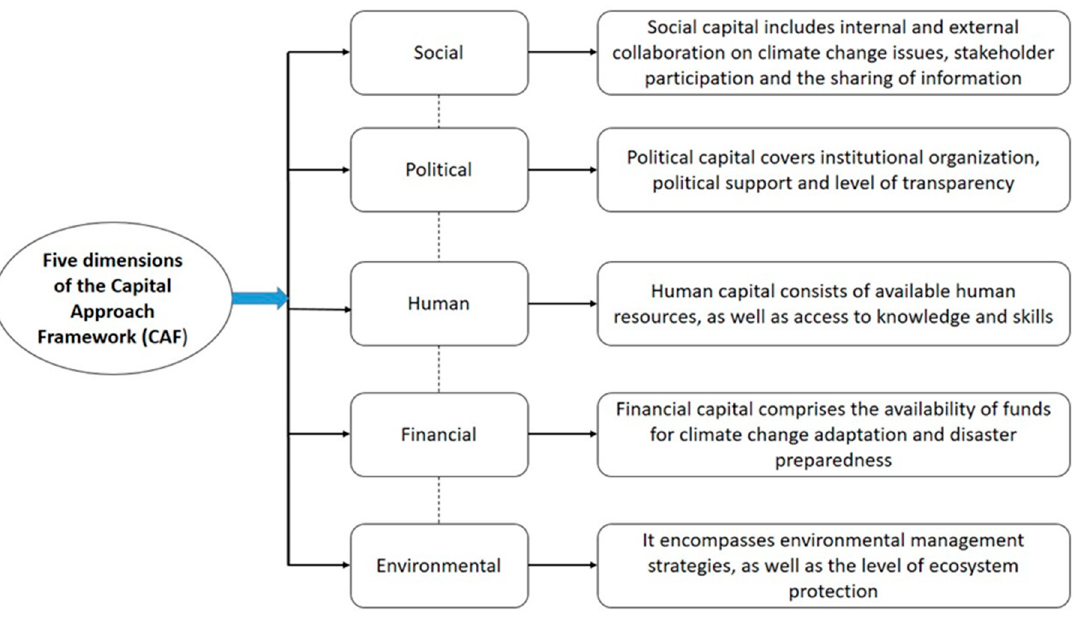
Figure 1. Description of the five types of capital as applied to the current study based on the CAF. Source: Inspired by Máñez et al. [38].